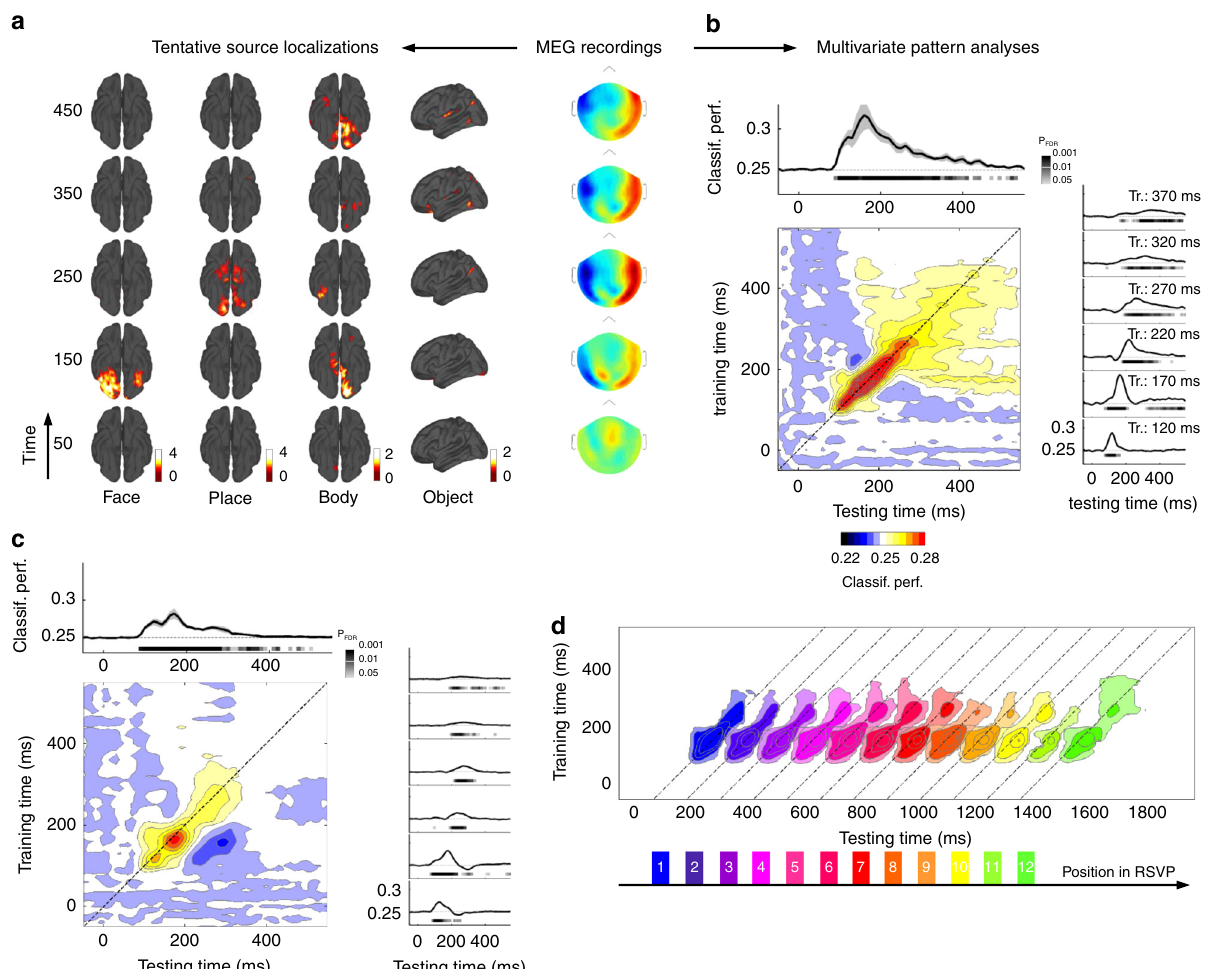
Fig. 2 Time-resolved decoding of stimulus categories. a Right: Example of event-related magnetic fi elds elicited by the presentation of images during the localizer task. Left: Subtraction between brain sources of each category (face, place, body parts and objects) and the mean of the other categories presented in Z scores according to baseline and projected on a fl attened standard brain. Left to right columns represent bottom and left views of the brain at speci fi c time points (50 – 450ms from bottom to top). b Performance of classi fi ers trained to separate the four stimulus categories. Top graph: One classi fi er was trained at each time sample and tested on the same time sample. The shaded gray area represents the standard error to the mean across subjects. Right graphs: Classi fi ers were trained at speci fi c time samples (from 120 to 370ms) and tested on all other time samples. Results from signed rank tests comparing classi fi cation performance to chance are represented by the thick line below the x axis with darker colors representing lower P-values. False discovery rate (FDR) correction for multiple comparisons was applied across speci fi c training times (120 to 370ms), all testing times and conditions (RSVP and localizer). Matrix plot: Classi fi ers were systematically trained on each time sample and tested on all others. The color code represents the classi fi cation performance and the dotted line the diagonal of the matrix. c Classi fi ers trained on the localizer task were directly applied to the RSVP task. Line plots, matrix plot and statistics are as in b . d Contour plot representing classi fi cation performance signi fi cantly above chance obtained for each stimulus and averaged across subjects. Colors represent the successive stimuli in the RSVP (except T1) depicted below by a small rectangle. Dotted lines represent the diagonals of each matrix plot. FDR correction for multiple comparisons was applied across all training times, testing times and stimulus